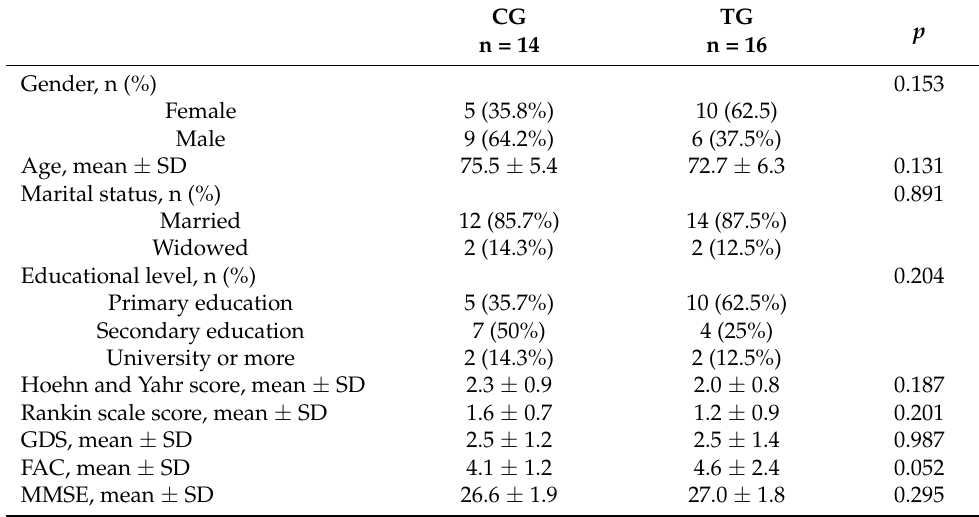
Table 1. Baseline demographic and clinical profile .